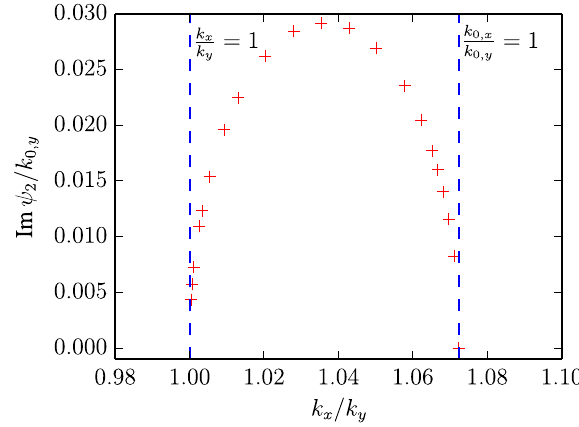
FIG. 4. Growth rate of difference odd mode (normalized) for constant k y =k 0 ;y ¼ 0 . 8 and ε x = ε y ¼ 2 as a function of the betatron tune ratio, indicating the tilting instability in a constant focusing